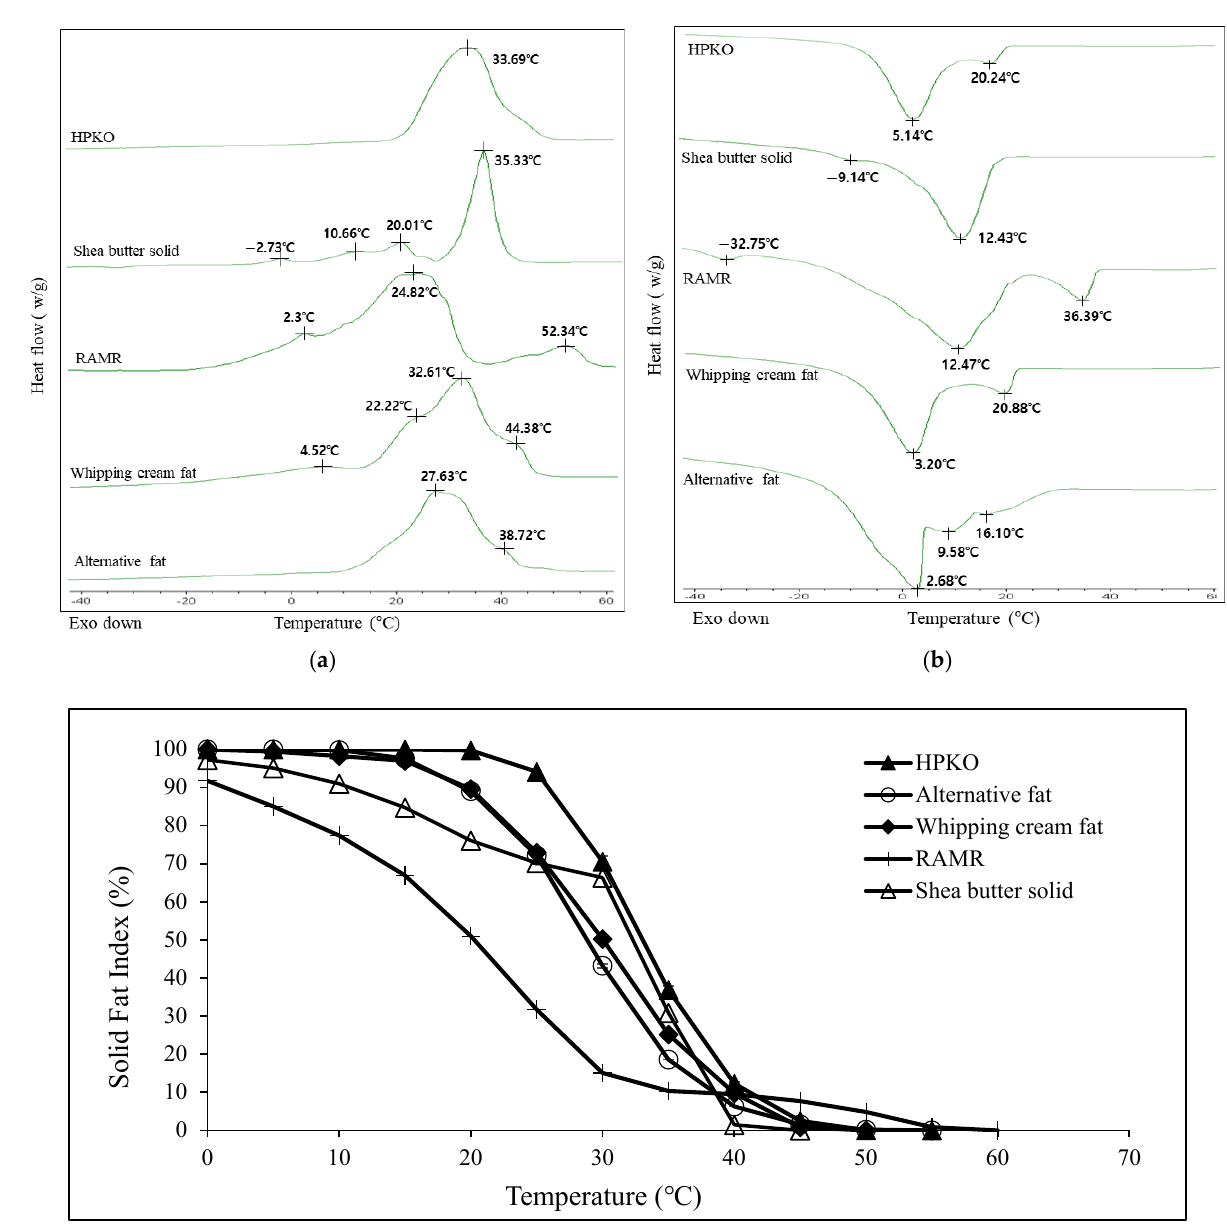
Figure 3. DSC melting ( a ) and crystallization ( b ) curves and solid fat index (SFI, ( c )) of hydrogenated palm kernel oil (HPKO), refined amyl migration reactant (RAMR), whipping cream fat, and alternative fat (HPKO:RAMR = 6:4 blend, w / w ).